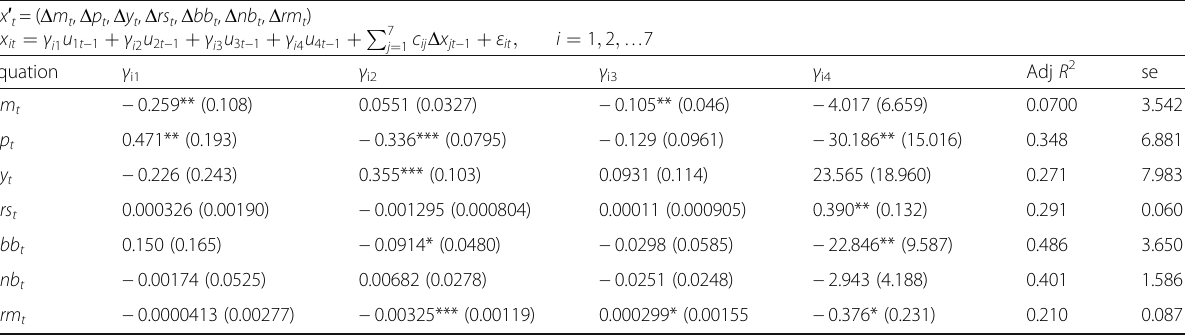
Table 3 EC model estimates M1, real income, price level, interest rates, and number of banks, Switzerland, 1851 – 1906 Δ x ′ Δ m Δ p Δ y Δ rs Δ bb Δ nb Δ rm t = ( t , t , t , t , t , t , t ) Δ